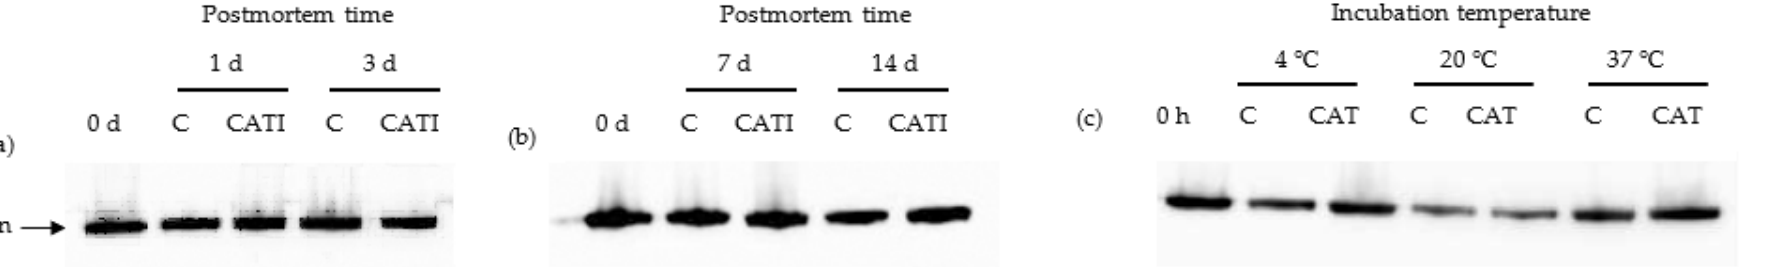
Figure 2. Representative western blotting patterns showing the degradation of α -actinin by cathepsin L in vivo and in vitro. ( a ) Samples treated with cathepsin L inhibitor for 0, 1, and 3 day postmortem at 4 °C in vivo; ( b ) samples treated with cathepsin L inhibitor for 0, 7, and 14 day postmortem at 4 °C in vivo; ( c ) samples incubated with cathepsin L for 10 h at 4, 20, and 37 °C in vitro.